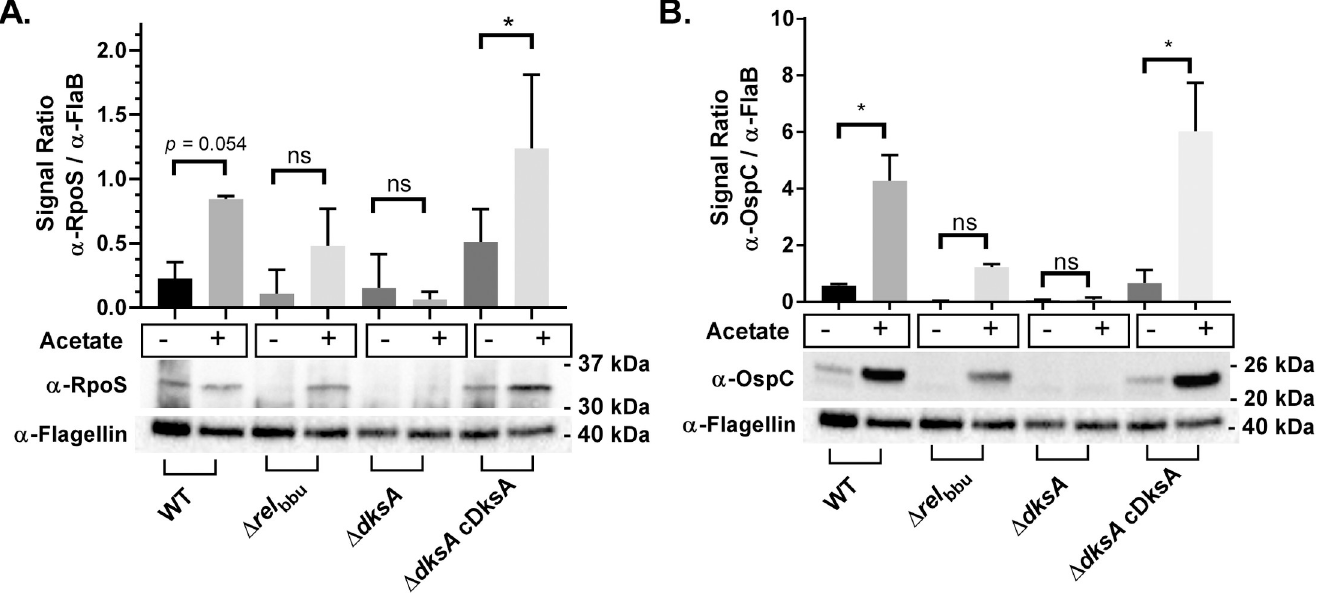
Fig 4. Relative expression of RpoS and OspC in wild-type (WT), Δ rel bbu , Δ dksA , and Δ dksA cDksA (cDksA) B . burgdorferi strains at mid-logarithmic growth. Whole cell lysates were collected from B . burgdorferi 297 strain cultured to 5 x 10 7 spirochetes/mL in either BSKII-pH 7.6 (acetate -) or BSKII-pH 6.7 with 20 mM acetate (acetate +). Expression of RpoS (A) and OspC (B) protein levels were determined by normalizing densitometry of chemiluminescence signals obtained from western blot to signals obtained from flagellin. Data are representative of 3 replicate experiments. Asterisk indicate adjusted p -values < 0.05 in a Sidak multiple comparisons test.